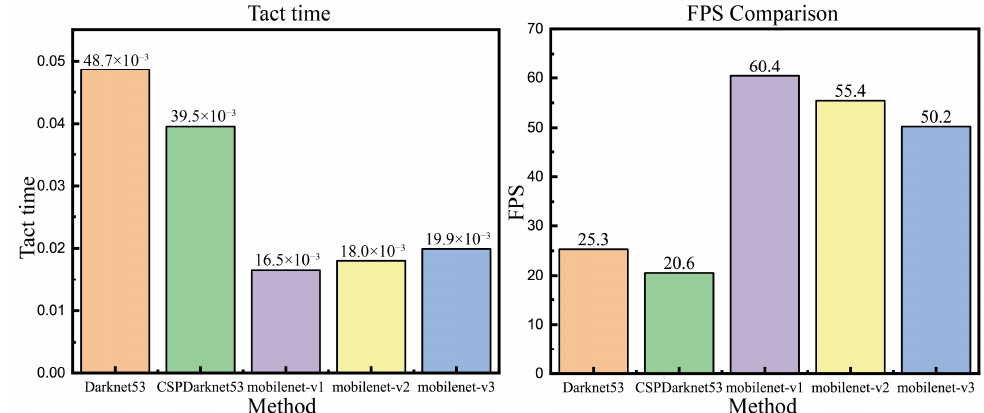
Figure 21. Comparison of the single image processing speed of five algorithms.